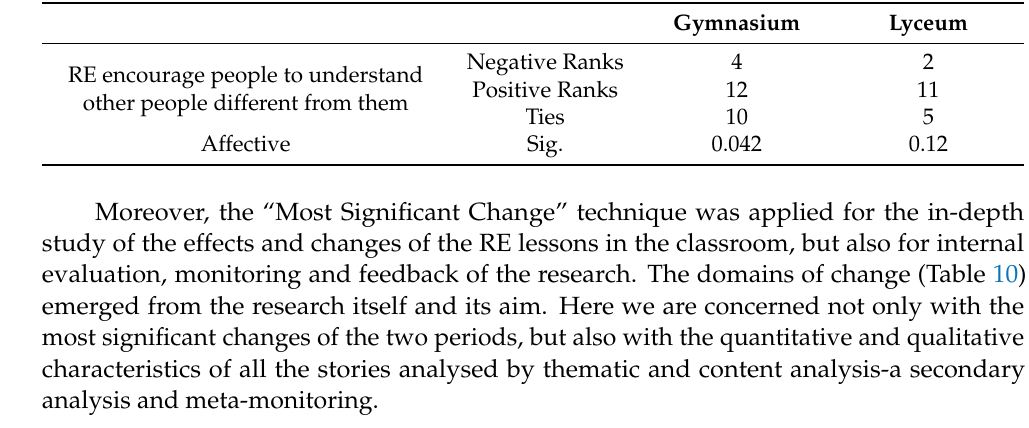
Table 10. Domain of change emerged from the students’ most significant stories and their frequency. Students’ Domains of